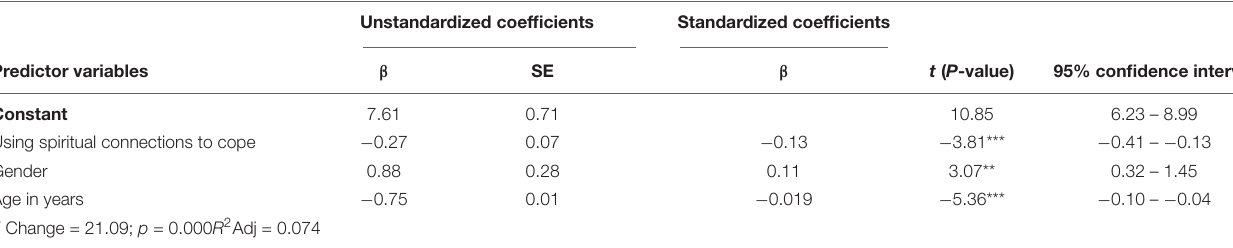
TABLE 3 | Multiple linear regression model: anxiety as dependent variable ( n =